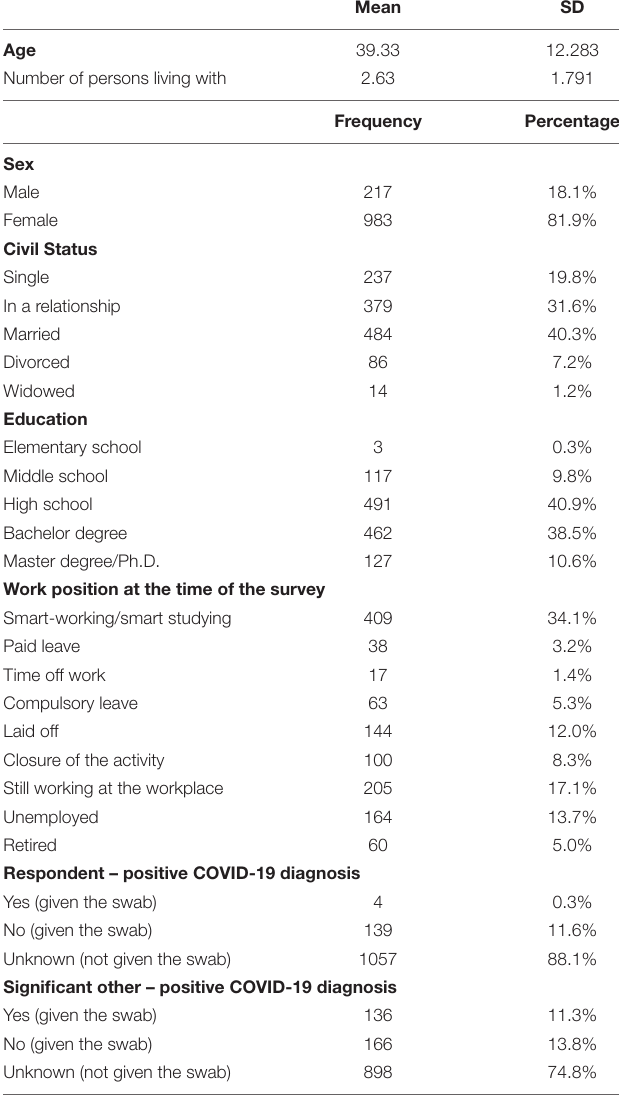
TABLE 1 | Socio-demographic characteristics of the